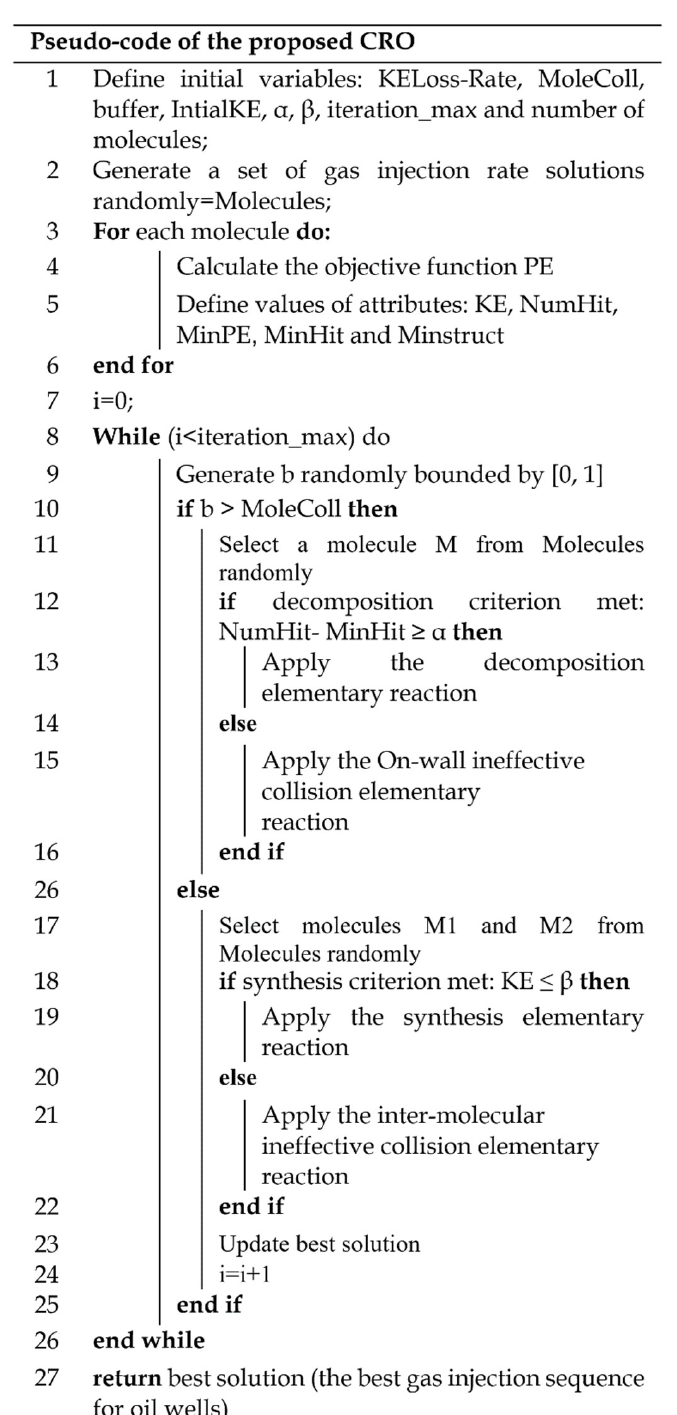
Figure 3. Pseudo-code of the proposed CRO for gas lift allocation problem.